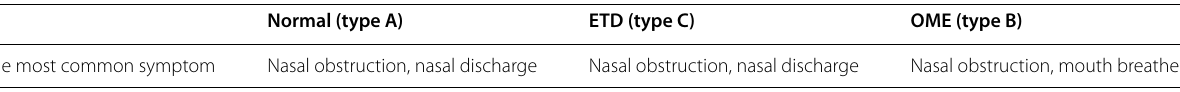
NP Nasal polyposis, ETD Eustachian tube dysfunction, OME Otitis media with